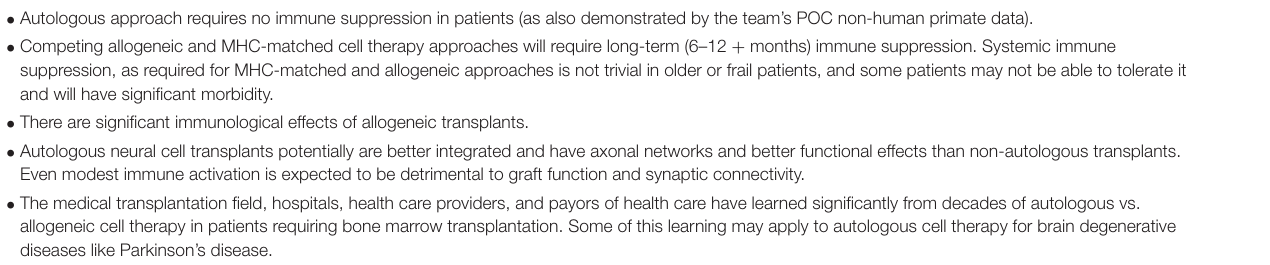
TABLE 1 | Adavantages of autologous transplantation for Parkinson’s